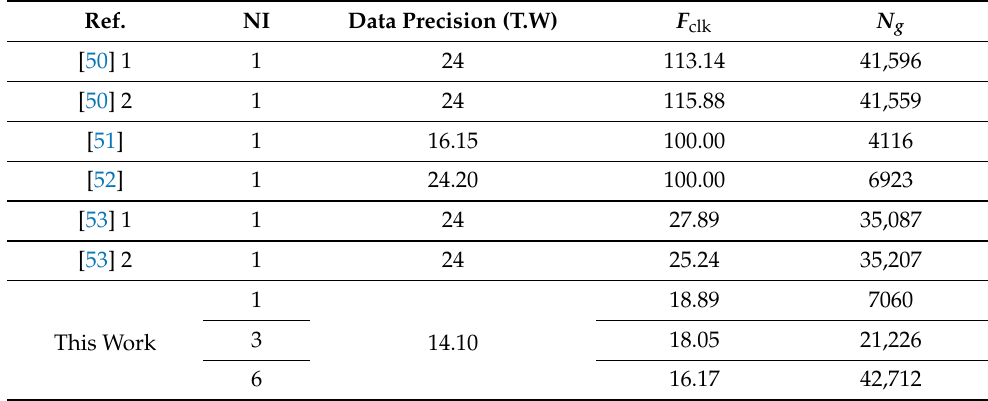
Table 18. Analysis of the frequency regarding Ng.